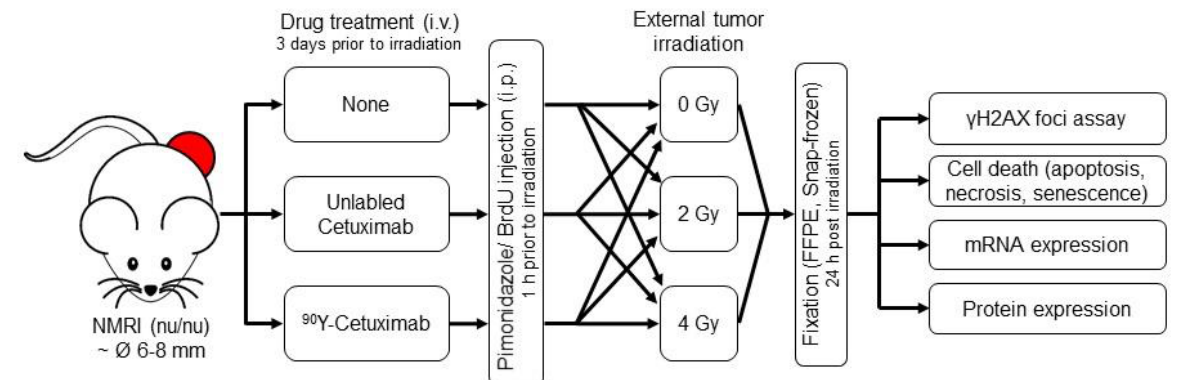
Figure 1. Overview of the animal experiment. Schematic illustration of the animal experiment. The experiment was carried out in two cohorts in parallel to the preclinical trial testing treatment efficiency published in [12]. Upon reaching a tumor diameter of 6–8 mm, animals were allocated to nine different treatment arms. Drugs were injected intravenously 3 days prior to irradiation. Pimonidazole (hypoxic marker) and bromodeoxyuridine (BrdU; proliferation marker) were administered intraperitoneally 1 h before tumors were locally exposed to external irradiation with 0, 2 or 4 Gy. Tumors were fixed 24 h post irradiation and the fixed samples were used for further molecular analysis. The total number of animals in each treatment arm is shown in Table S1.